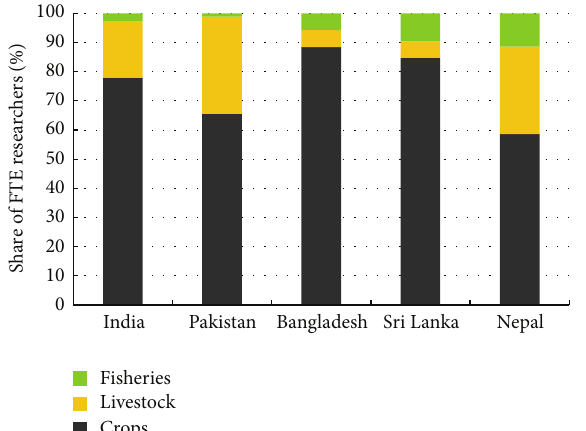
Figure 2: Researcher focus by major commodity area, 2009. Source: the state of food insecurity in the world, 2012, FAO report.